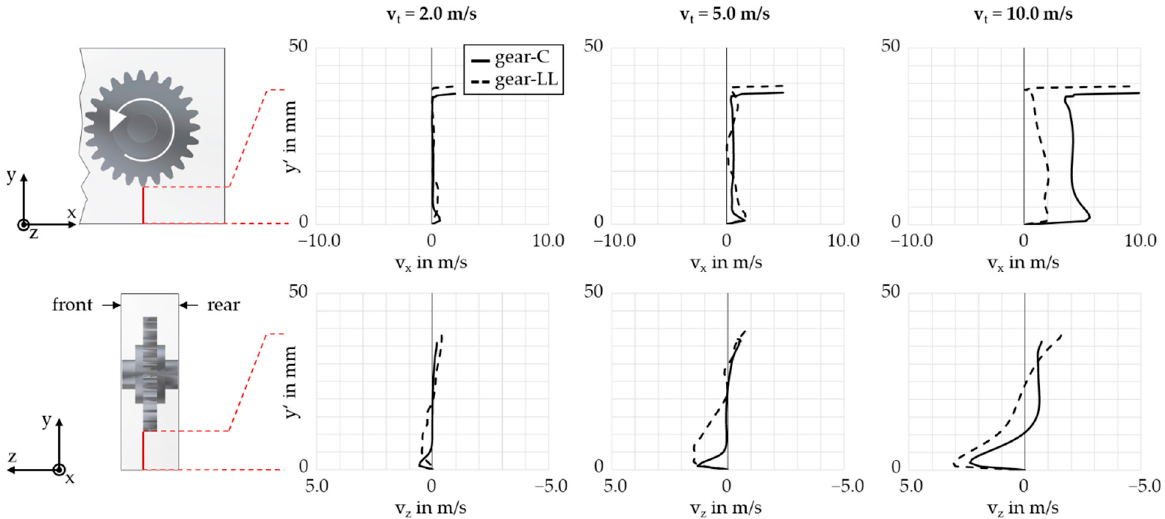
Figure 6. Flow velocities v x and v y below the wheel of gear-C and gear-LL for v t = {2.0; 5.0; 10.0} m/s.